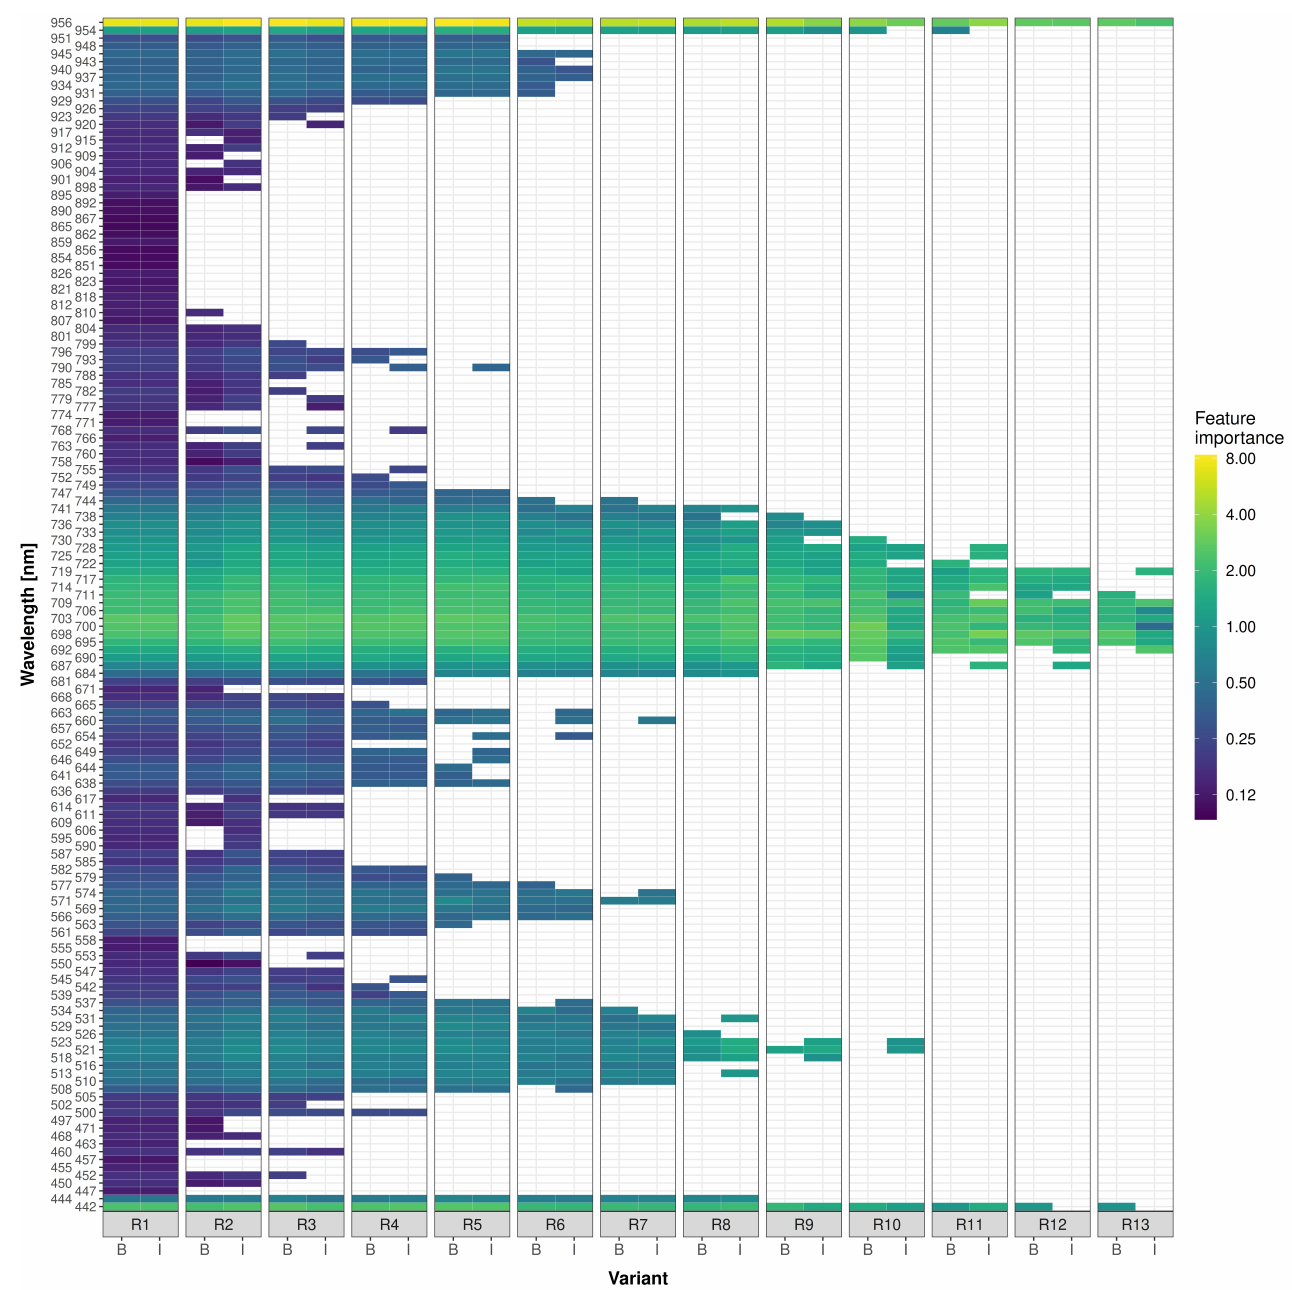
Figure 6. Feature importance for each predictor comparing a direct reduction from the baseline variant (B) and a reduction with intermediate training after every reduction step